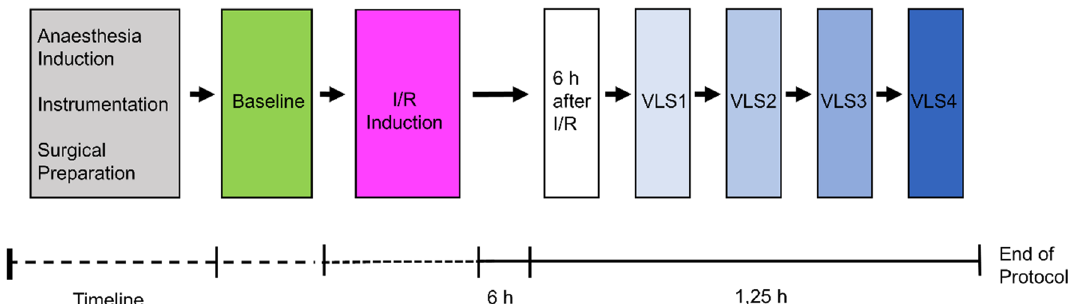
Figure 1. Experimental protocol. After completion of anesthesia induction, instrumentation and surgical preparations, baseline measurements were performed. Thereafter, ischemia/reperfusion (I/R) was induced. 6 h after ischemia/reperfusion induction, measurements were repeated and 4 consecutive volume-loading-steps (VLS)